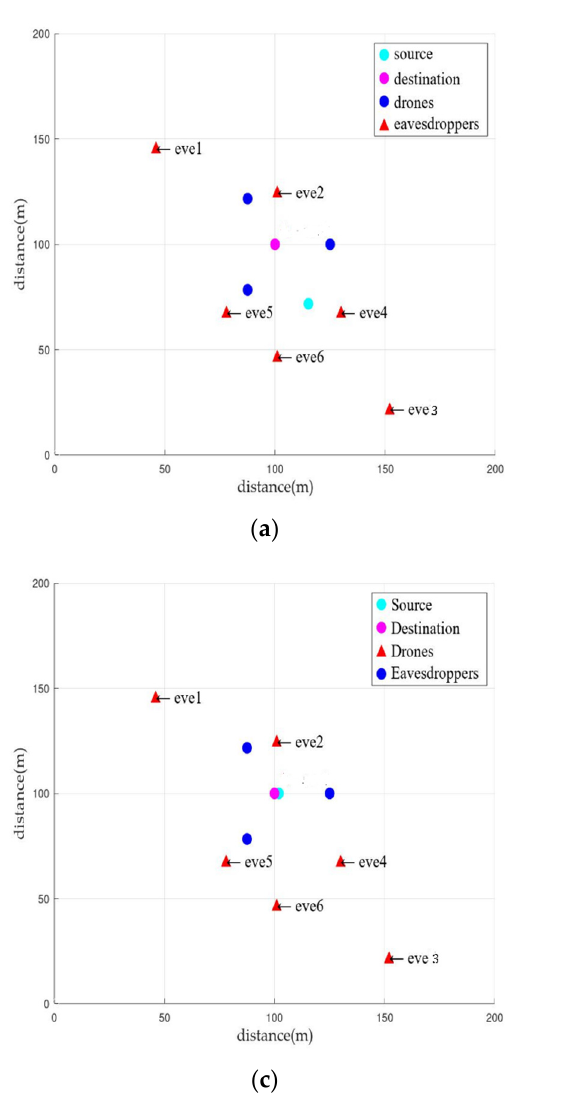
Figure 4. Network configuration for CFJ-DMZ simulation: ( a ) None mobility and None friendly jamming, ( b ) None mobility and Friendly jamming, ( c ) Mobility and None friendly jamming, and proposed scheme ( d ) Mobility and Friendly jamming. Table 2. Location of each node in